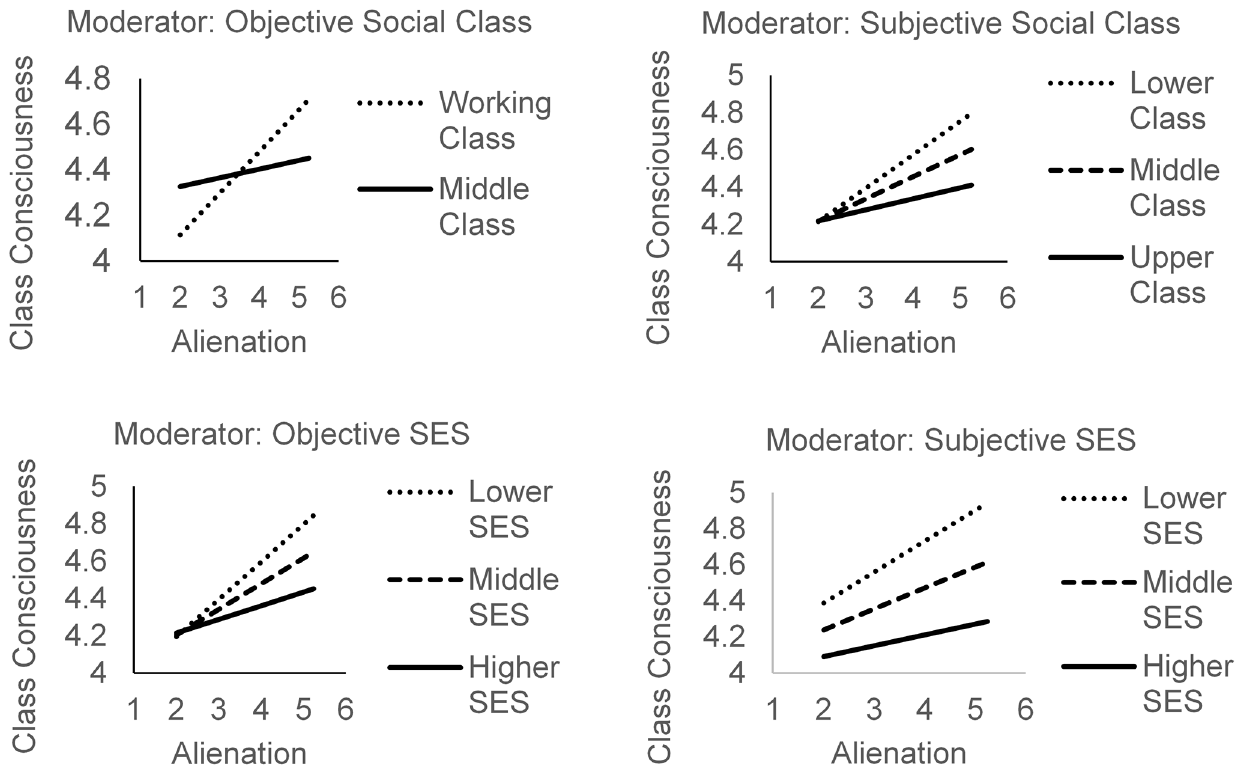
Figure 1. In Study 1, the relation between alienation and class consciousness was stronger among lower-class/lower-SES